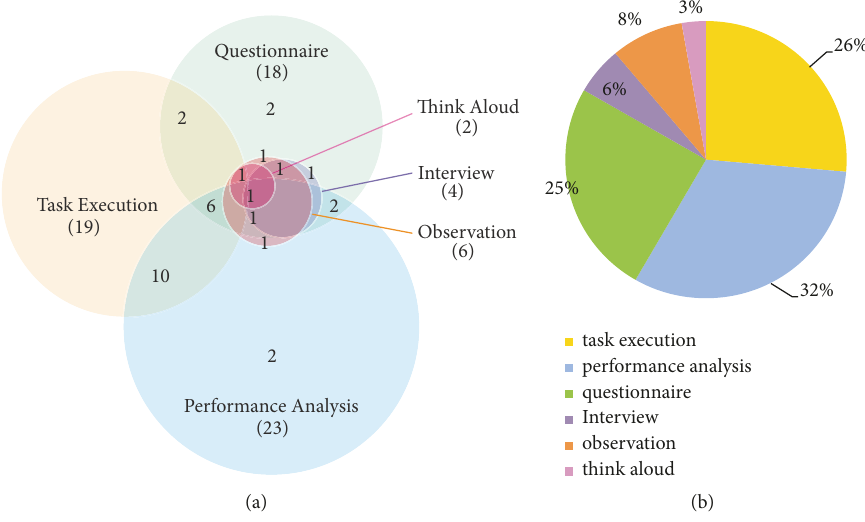
Figure 4: Method used in articles numbers (a) and percentage (b).